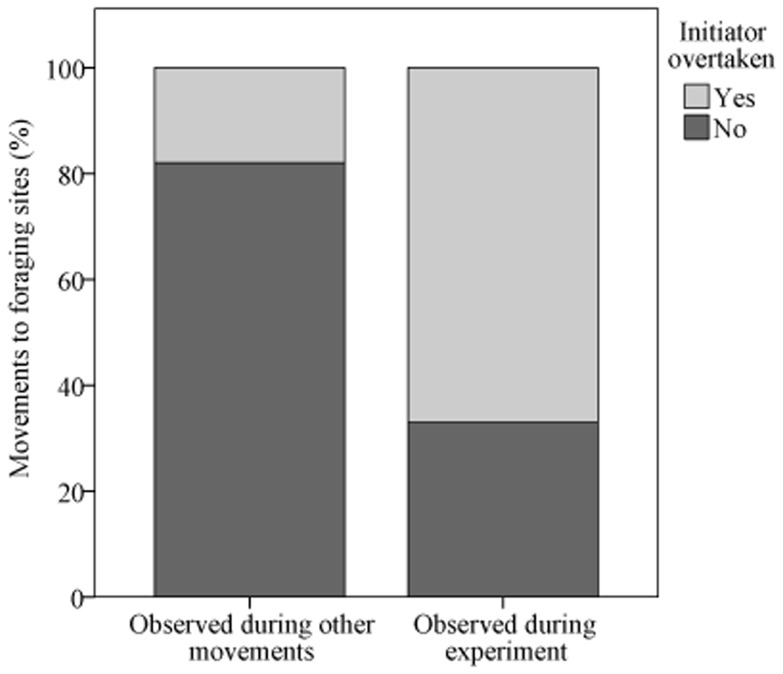
Overtaking events (in percent) during movements towards drinking platforms compared to other foraging movements of the group observed during the same time period.
N = 15 observations of group movements for the experiment, N = 57 observations of group movements for other observations.